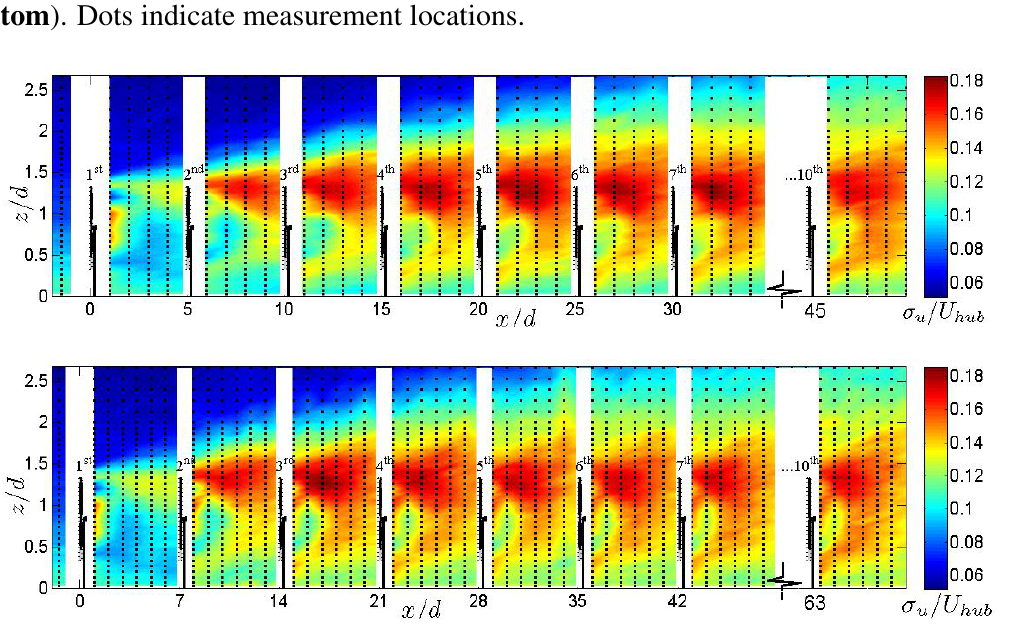
= 5 ( top ) and S = 7 x x